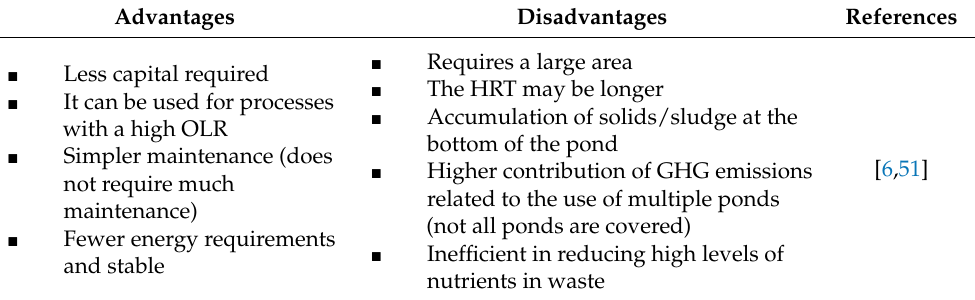
Table 2. Advantages and disadvantages of conventional pond